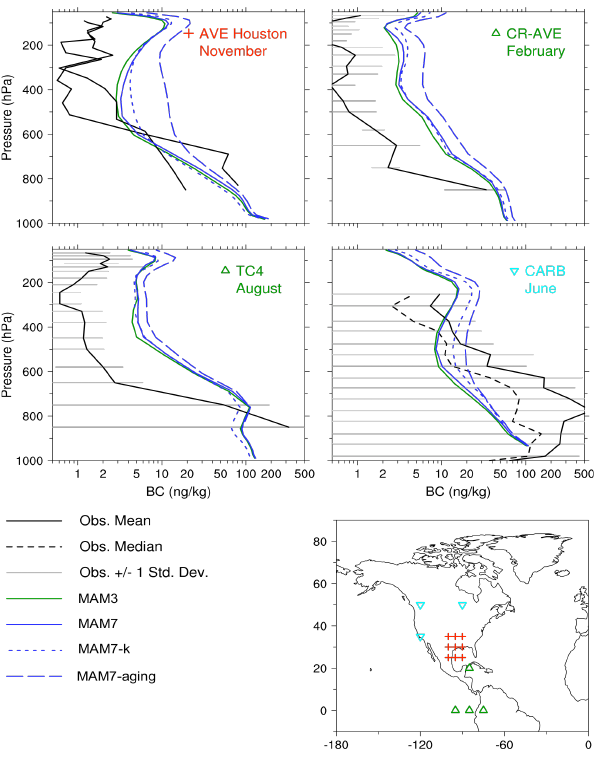
Fig. 15. Observed and simulated BC vertical profiles in the tropics Figure 15. Observed and simulated BC vertical profiles in the tropics and middle latitudes from 4 aircraft campaigns: AVE Houston (NASA Houston Aura Validation and middle latitudes from four aircraft campaigns: AVE Houston Experiment), CR-AVE (NASA Costa Rica Aura Validation Experiment), TC4 (Tropical (NASA Houston Aura Validation Experiment), CR-AVE (NASA Composition, Cloud and Climate Coupling), and CARB (NASA initiative in Costa Rica Aura Validation Experiment), TC4 (Tropical Composi- tion, Cloud and Climate Coupling), and CARB (NASA initiative in collaboration with California Air Resources Board). Observations are averages for the respective campaigns and were measured by three different investigator groups: NOAA (Schwarz et al., 2006) for AVE-Houston, CR-AVE, and TC4; University of Tokyo (Moteki and Kondo, 2007; Moteki et al., 2007) and University of Hawaii (Clarke et al., 2007; Howell et al., 2006; McNaughton et al., 2009; Shinozuka et al., 2007) for CARB. The Houston campaign has two profiles from two different days. See Koch et al. (2009) for addi- tional details. Simulated profiles for MAM3 and MAM7 are aver- aged over the points on the map and the indicated month. Two sen- sitivity experiments are included: MAM7-k and MAM7-aging, as discussed in Sect. 5.